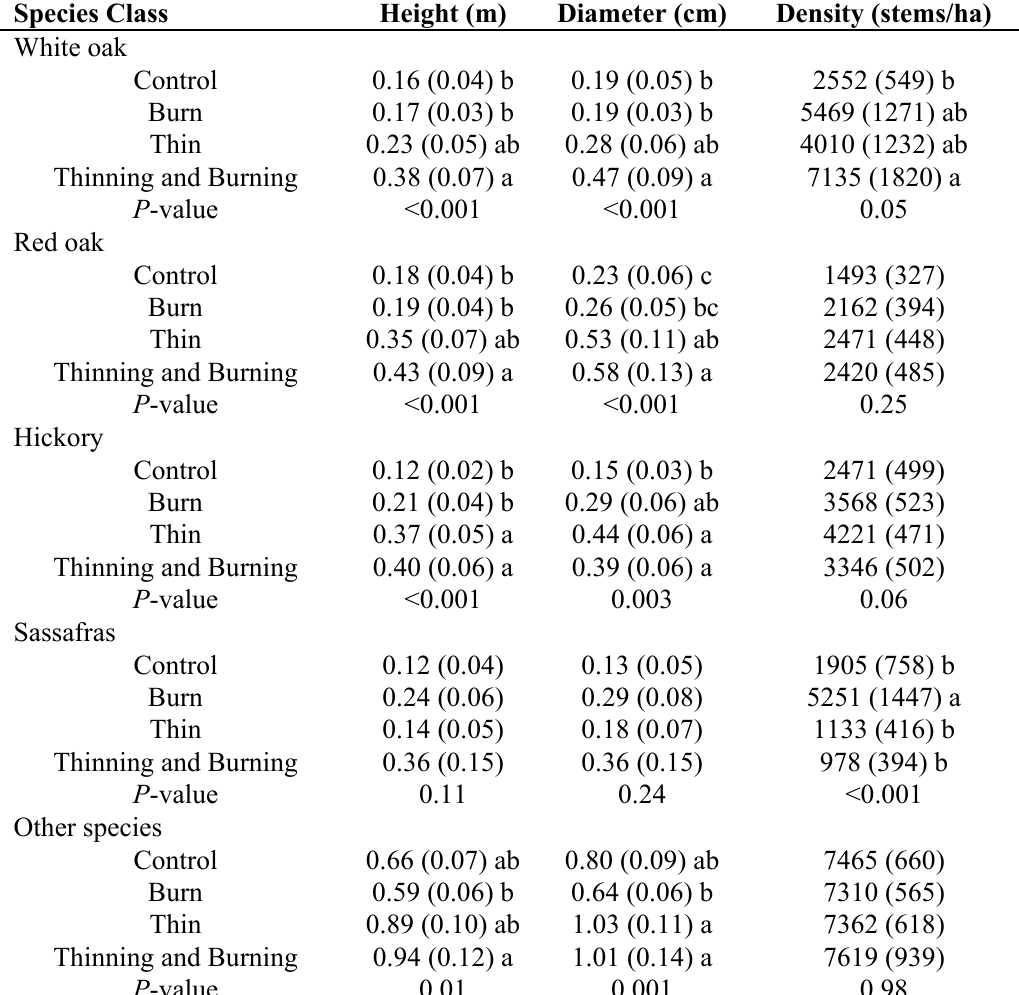
Table 2. Mean (S.E.) height and diameter (of the tallest seedlings) and density of all large seedlings (>20 cm in height) by species class and treatment. Means were separated by Tukey option for post-hoc comparisons when ANOVA revealed a clear difference between treatments ( P < 0.05) for each species class and treatment.